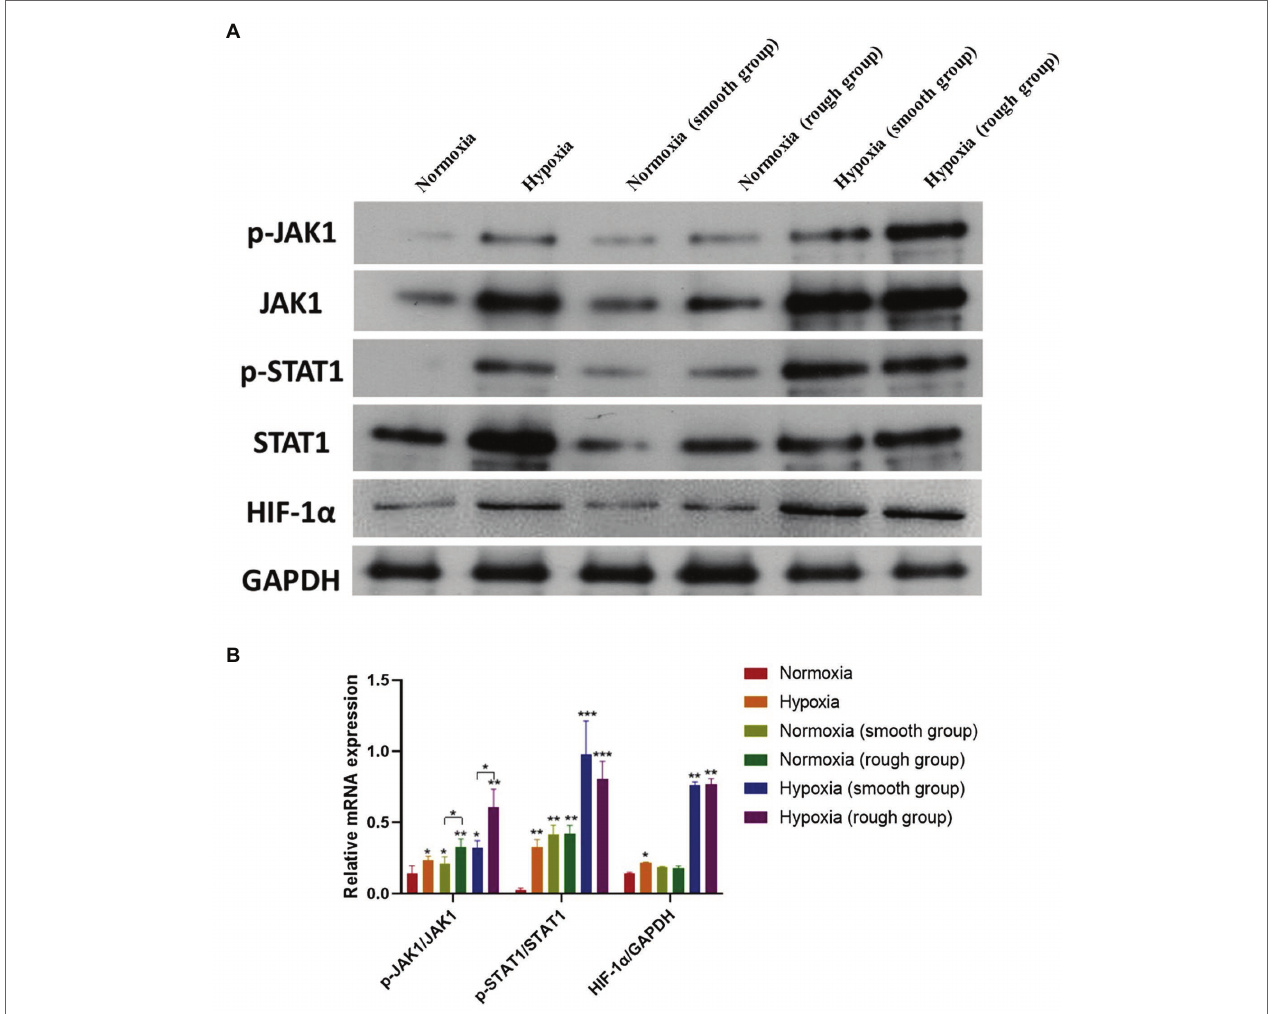
FIGURE 5 | The JAK1/STAT1/HIF-1 α pathway activation in different groups. (A) Protein expression of p-JAK1, JAK1, p-STAT1, STAT1, HIF-1 α , and GAPDH; (B) Relative protein expression of p-JAK1/JAK1, p-STAT1/STAT1, and HIF-1 α /GAPDH. * p < 0.05, ** p < 0.01, and *** p < 0.001, *compared with the corresponding group maintained under normoxic